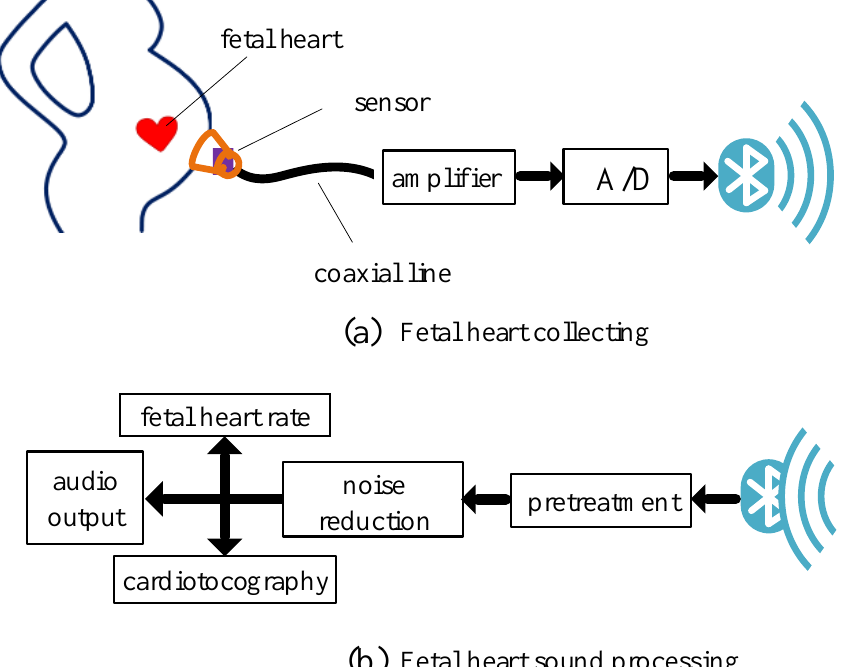
Figure 1. Structure of the fetal heart sound monitoring system.